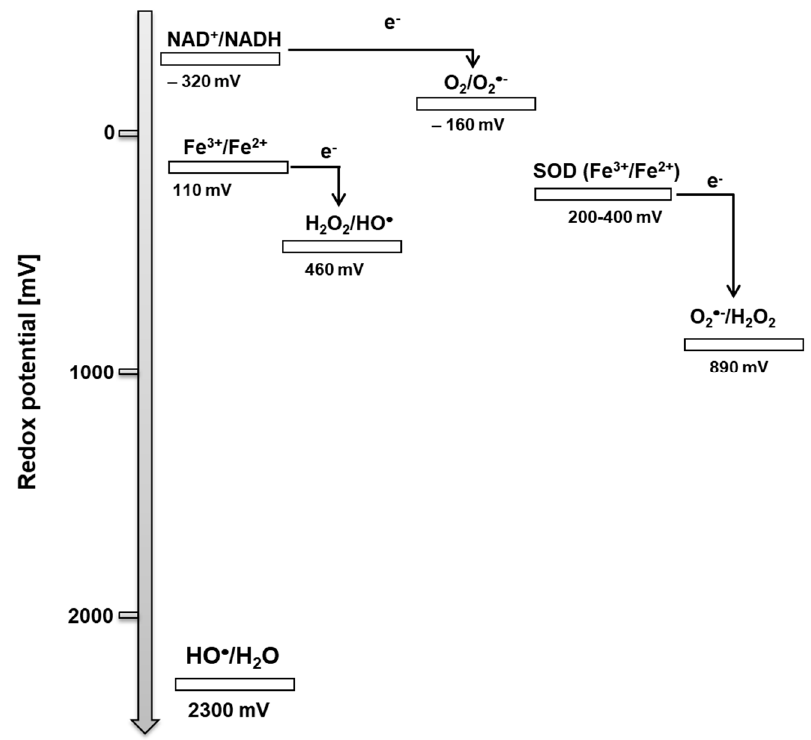
Figure 3. The oxidative properties of ROS. One-electron standard ( E ’ 0 ) and midpoint ( E m) redox potentials (pH 7) for redox couples involved in the formation of ROS.